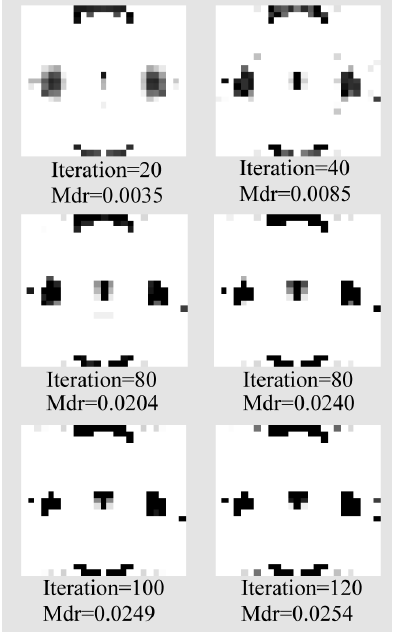
Fig. 18. Optimal distribution of damping material at different iteration numbers, vf = 0.2.